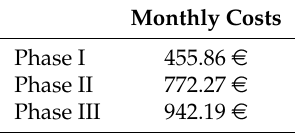
Table 5. Placement costs in a specialized